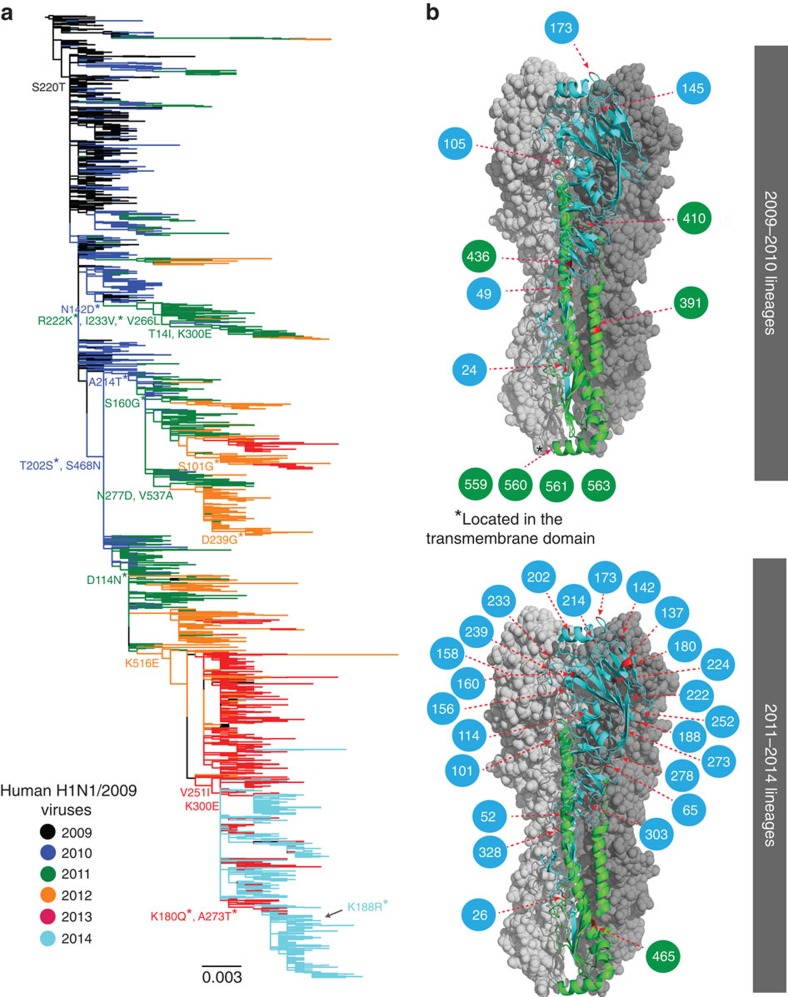
Evolution of human H1N1/2009 viruses and structural mapping of positively selected sites on the HA molecule.(a) Maximum likelihood phylogeny of 2,280 human H1-HA sequences from 2009 to 2014 with branches coloured by year of virus isolation. Representative amino-acid substitutions are mapped at the major tree nodes. Sites marked with asterisks (*) indicate positively selected sites identified by MEME method, with the significance level at P<0.05. Scale bar represents number of substitutions per site. (b) Mapping of positively selected amino-acid sites identified by MEME method onto the three-dimensional structure of the HA glycoprotein of H1N1/2009 virus (Protein Data Bank code: 3LZG) for the pandemic (2009–2010) and post-pandemic (2011–2014) periods. The monomer shows the HA1 subunit in light blue and the HA2 subunit in green. The numbers in coloured circles denote codon alignment number and their locations in the three-dimensional structure are indicated with red arrows.